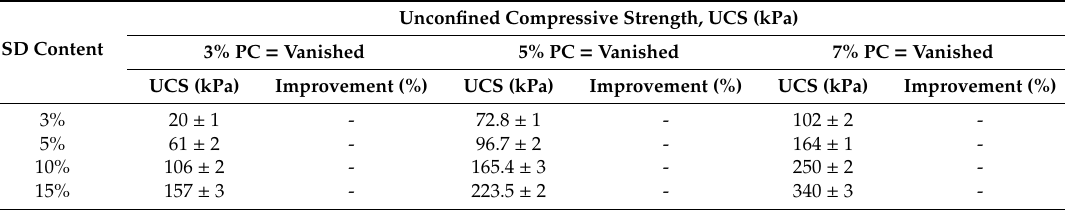
Table 5. UCS results after sulphate exposure in presence of SD (3 days